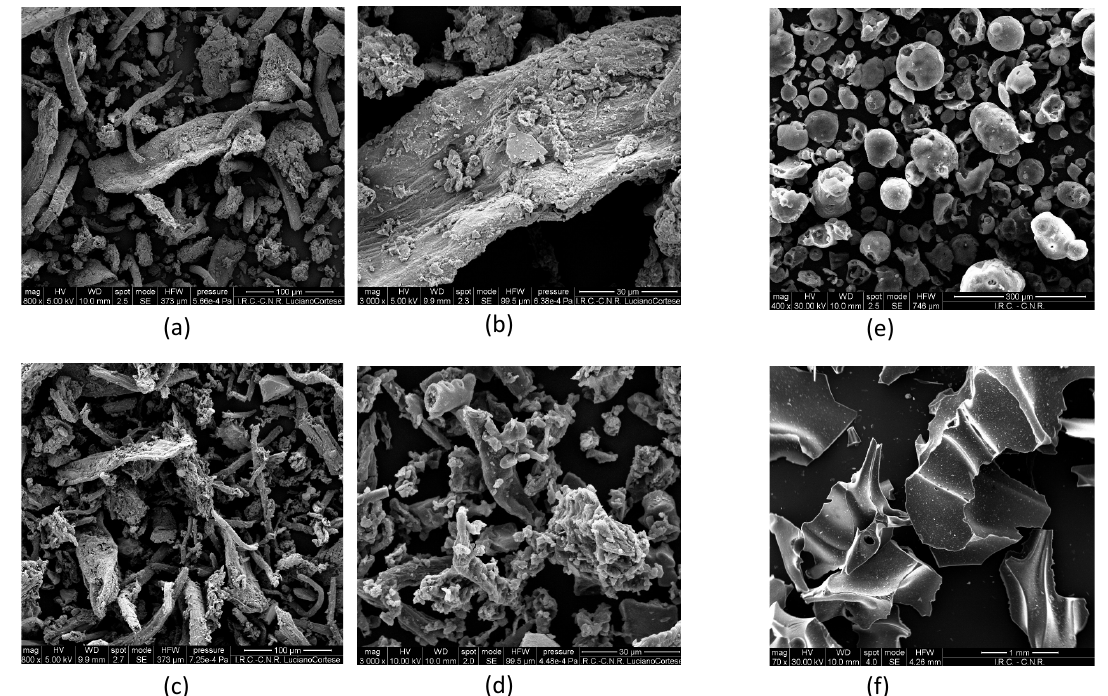
Figure 6. SEM analysis LRR ( a , b ), LRR char at 600 ◦ C ( c , d ); alkali lignin ( e ), alkali lignin char, ( f ) at 600 ◦ C adapted from [19].